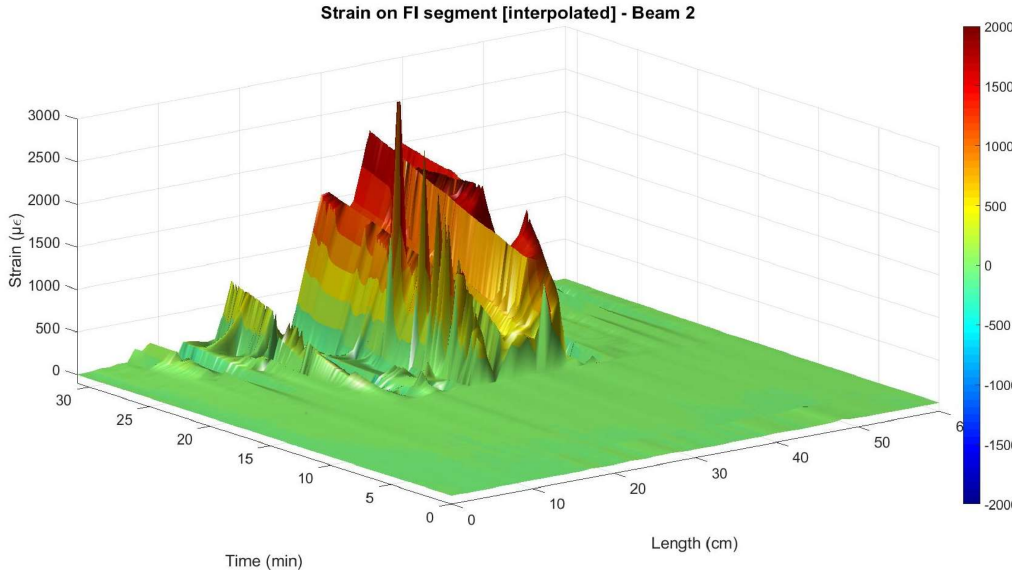
Figure 20. Interpolated measured strain at the embedded segment in Beam 2.